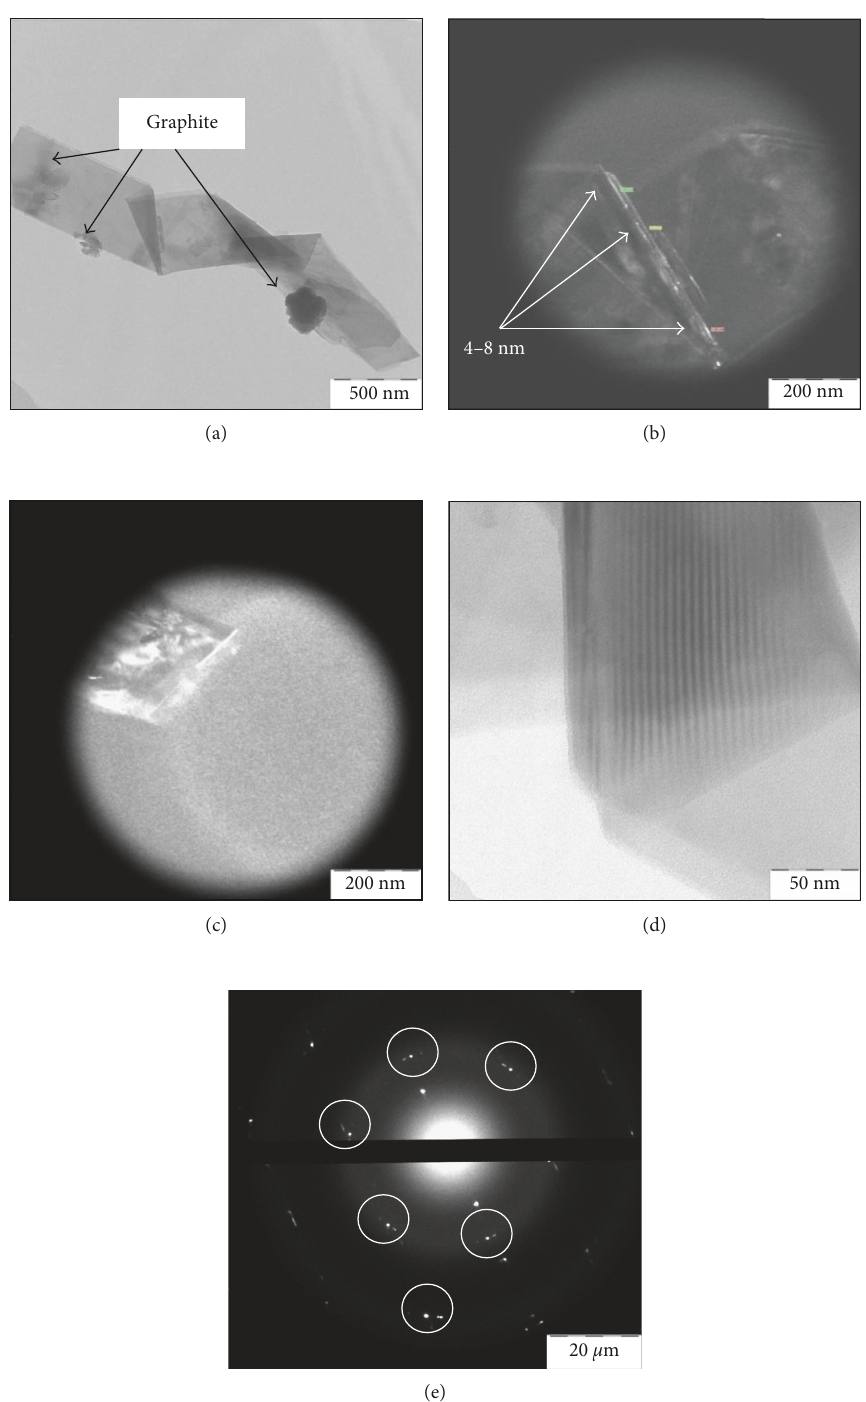
Figure 8: TEM images of the Gr 2 fraction. (a) The tape with graphite particles, retaining it. (b) Dark-field microphoto of the graphene tape bending region. (c) Dark-field microphoto of graphene tape edge with moir´e. (d) 3D stack. (e) Electron diffraction pattern (the circles indicate reflexes